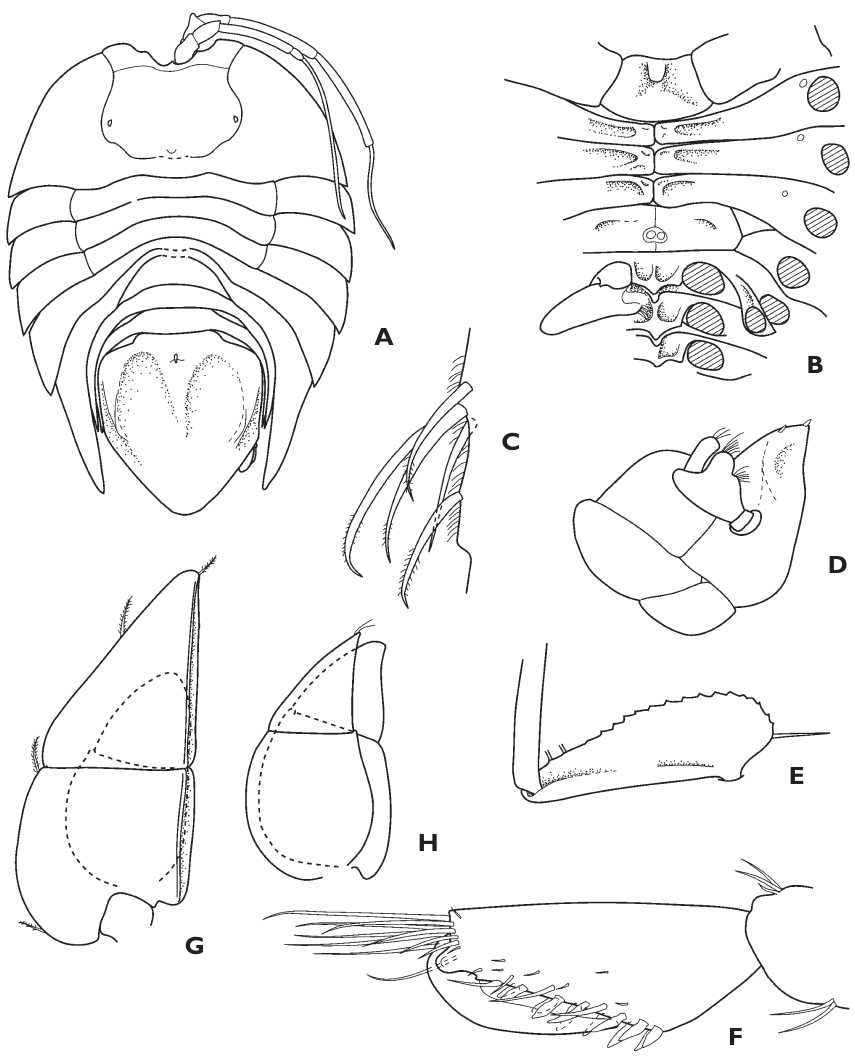
Figure 19. Myopiarolis novaecaledoniae . Holotype. A dorsal view B sternites and ventral pleonites C pereopod 6 carpus inferior margin setae D maxilliped E pleopod 2 endopod, detail F pereopod 2 propodus and dactylus G pleopod 4 H pleopod